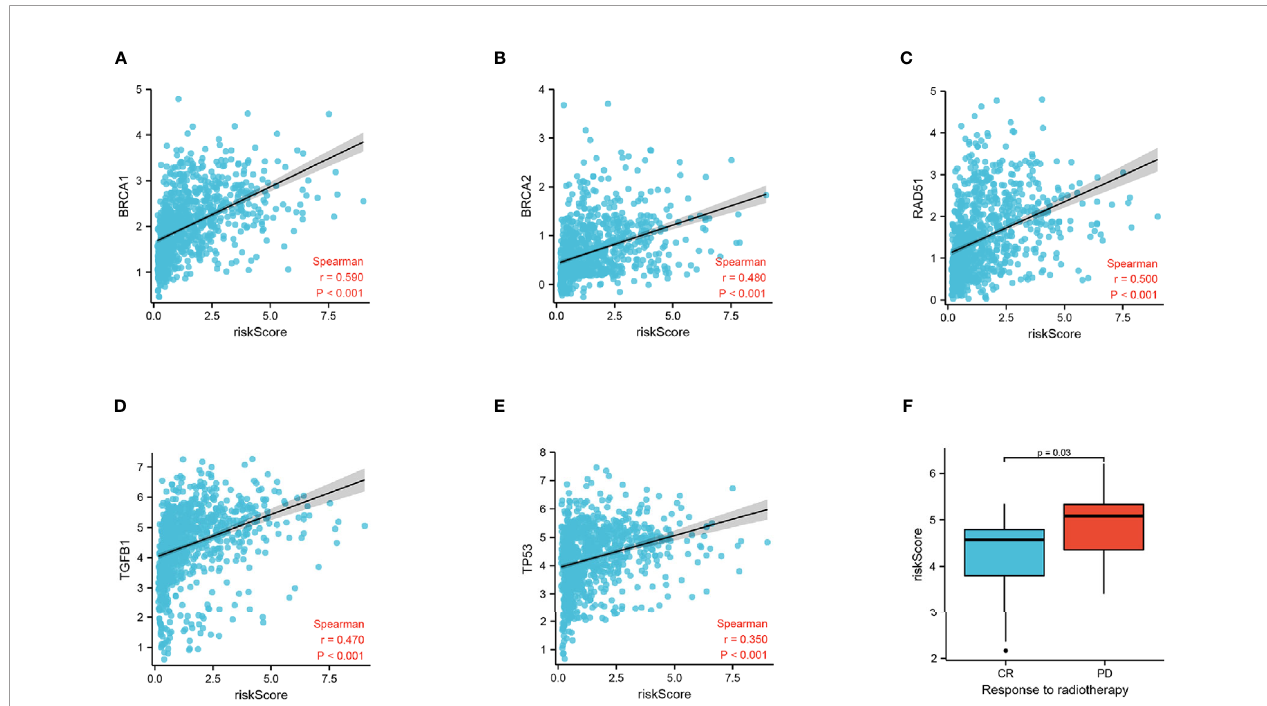
FIGURE 7 | Correlation of risk score and radiation response genes. (A) Correlation of risk score and BRCA1. (B) Correlation of risk score and BRCA2. (C) Correlation of risk score and RAD51. (D) Correlation of risk score and TGFB1. (E) Correlation of risk score and TP53. (F) Risk score of the CR and PD groups.